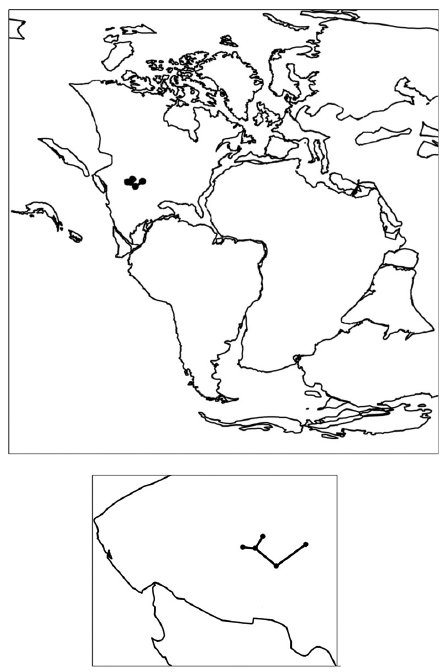
Fig. 2 - Carnian paleogeographic map showing the individual track of Diplurus longicaudatus , with a zoom of the occur- rences below.